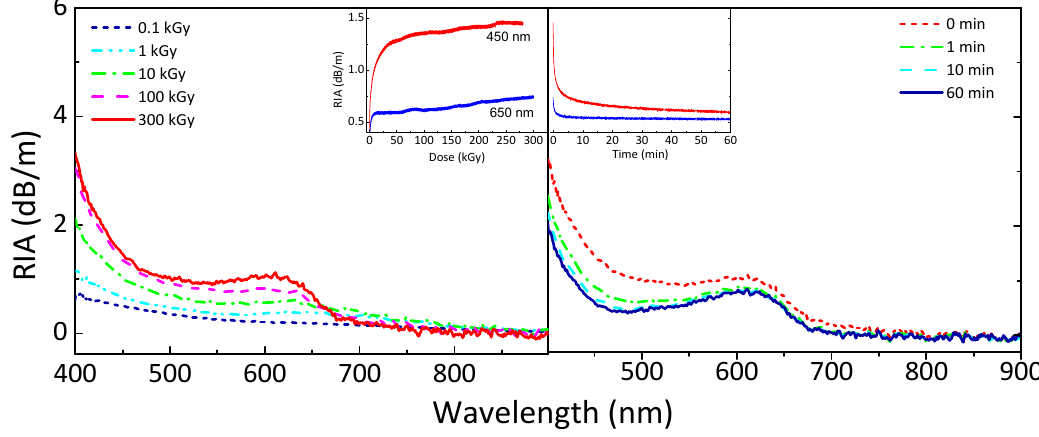
Figure 4. Radiation-induced attenuation (RIA) spectral growth during the irradiation (left) up to 300 kGy(SiO 2 ) and spectral decrease during the recovery (right) in the medium -OH+H 2 +TT sample. Both insets show the respective RIA kinetics at wavelengths of 450 nm and 650 nm.